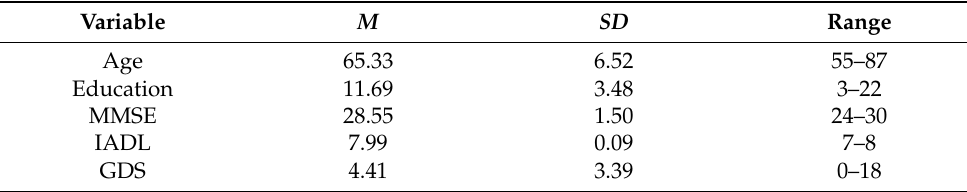
Table 1. Demographic statistics and performance on MMSE, IADL, and GDS.